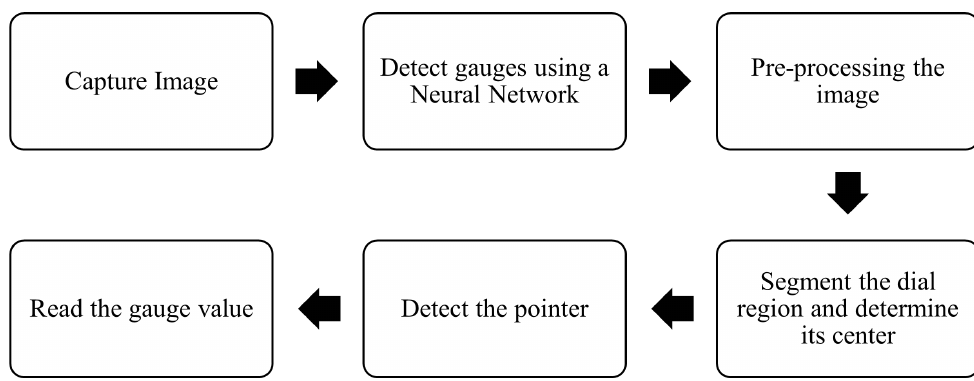
Figure 2. Flowchart of the proposed steps to read analog gauges.